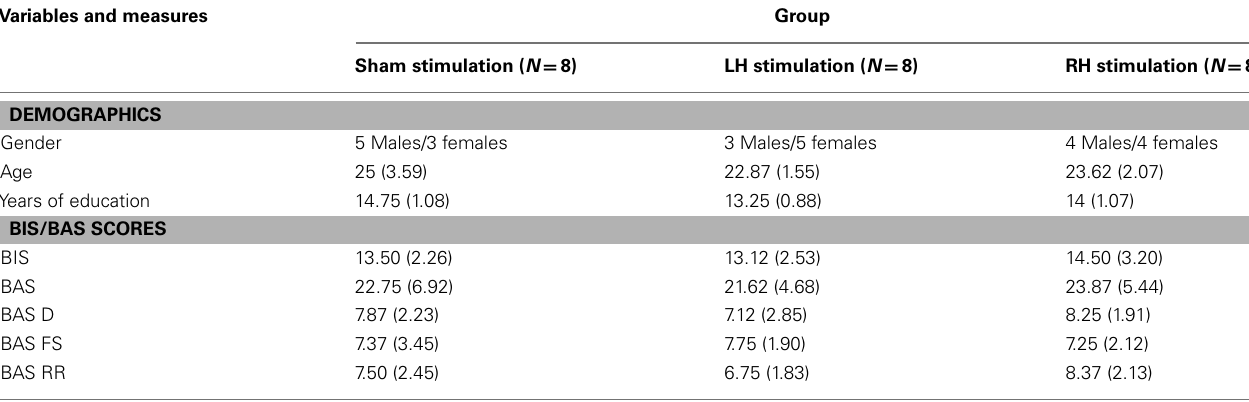
Table 2 | Demographics and motivation information for the Sham, LH, and RH stimulation